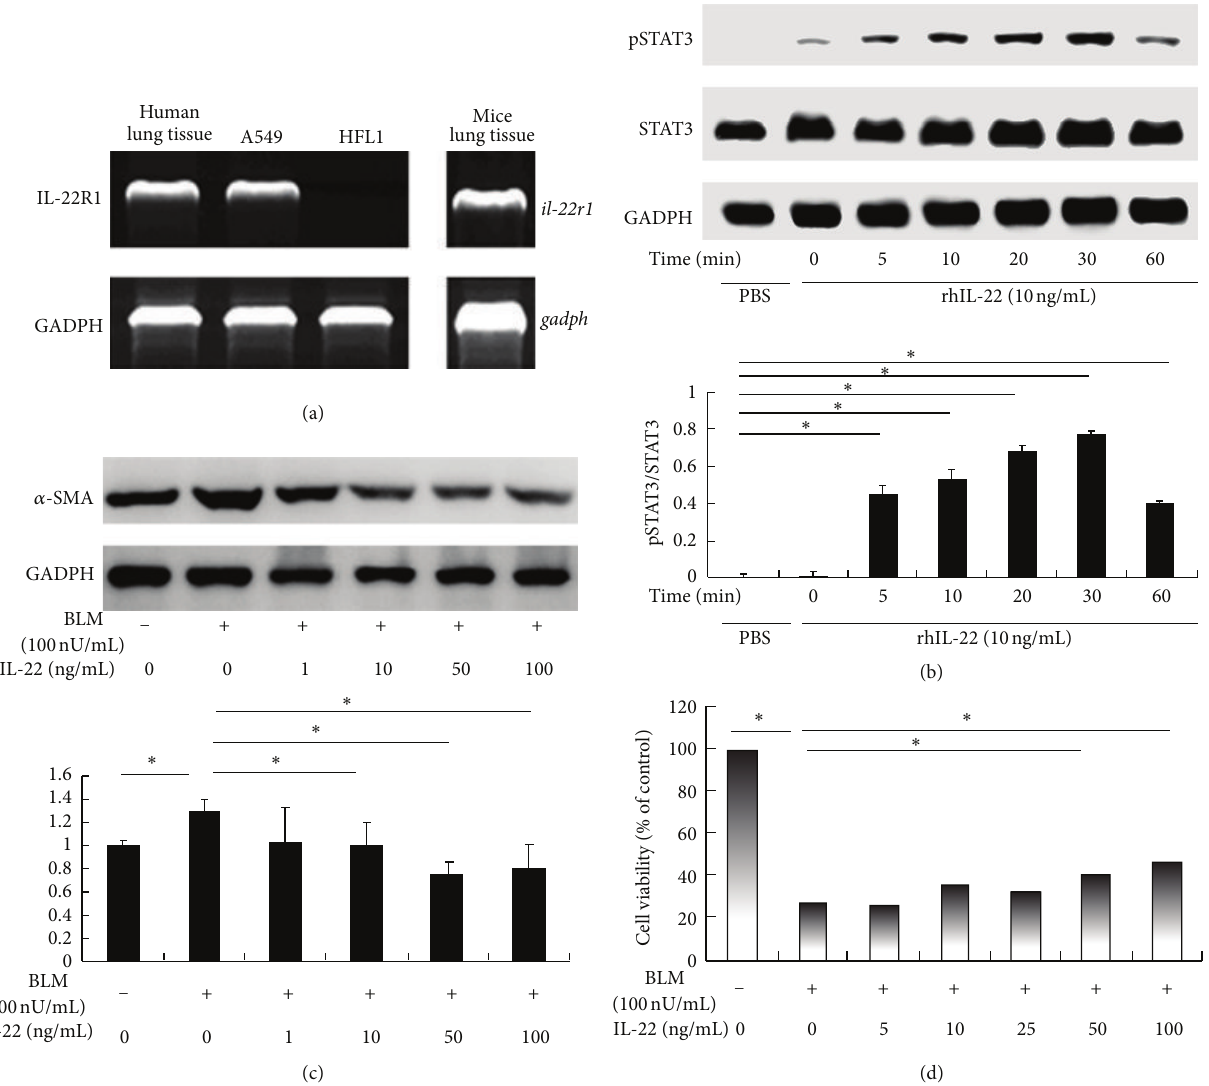
Figure 4: IL-22 attenuates bleomycin-induced epithelial mesenchymal transition (EMT) and impaired cell viability of alveolar epithelial cells. (a) Reverse transcription-polymerase chain reaction (RT-PCR) analysis was performed for IL-22R1 and GADPH on total RNA isolated from the whole lungs of human and mice, as well as human cell lines A549 and HFL1. PCR products were analyzed in ethidium bromide- 2% agarose gels. (b) Human alveolar epithelial cell line A549 was treated with 10ng/mL IL-22 at the indicated length of time. Levels of phosphorylated STAT3, total STAT3, and GADPH were determined by western blotting and analyzed by densitometry compared to GADPH expression. Fold increase in pSTAT3 expression after normalization to total STAT3 expression is shown. The experiments were performed thrice with similar results. (c) and (d) After induction by bleomycin (BLM) (100mU/mL), A549 was treated with or without IL-22 at the indicated concentrations for 48h. Protein levels of 𝛼 -smooth muscle actin ( 𝛼 -SMA) and GADPH were determined by western blotting in